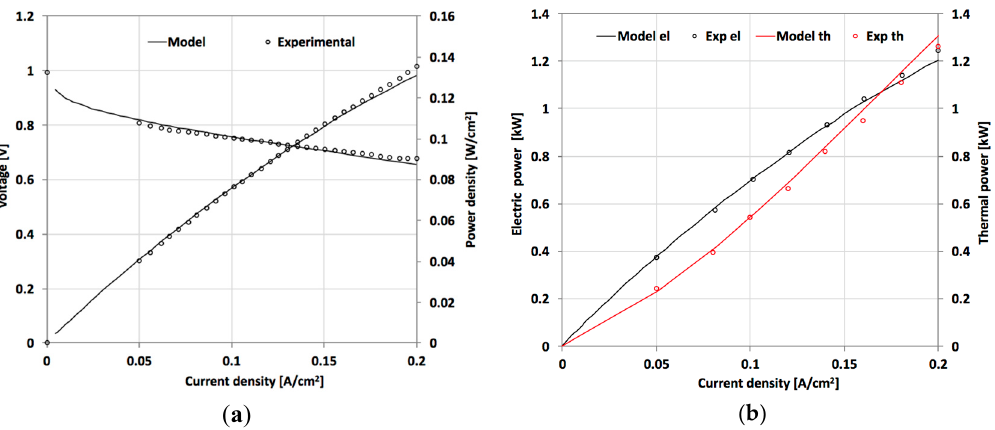
Figure 3. Comparison between numerical results and reference data in [30]: ( a ) Voltage and power density curves; ( b ) Electric and thermal power curves.